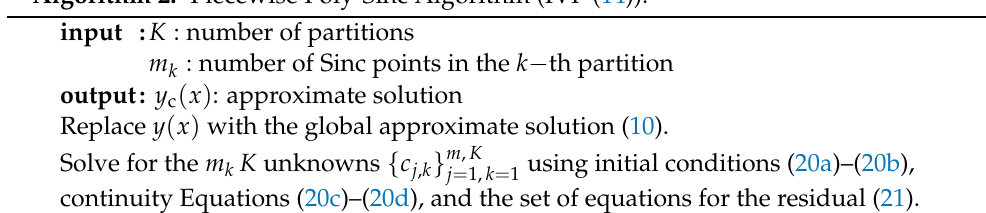
Algorithm 2: Piecewise Poly-Sinc Algorithm (IVP (14)).